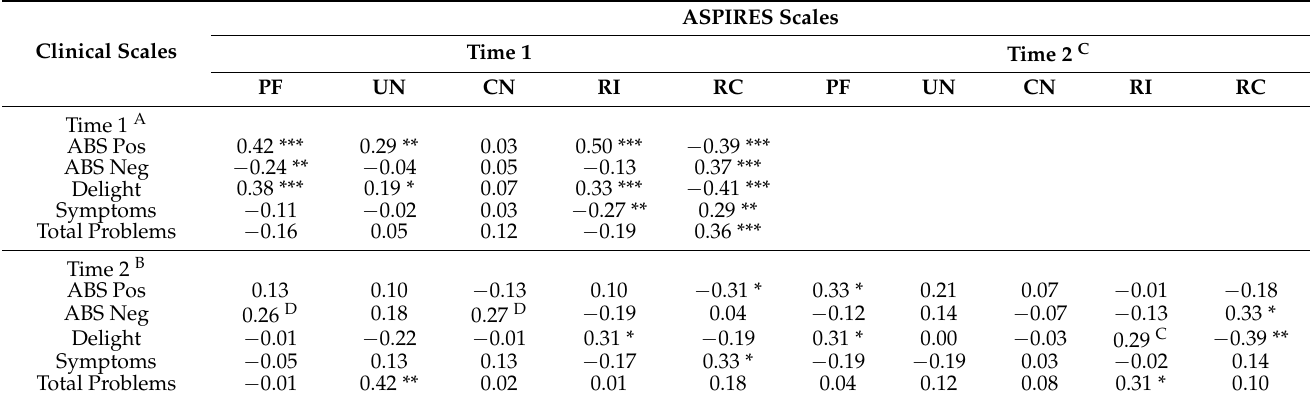
Table 4. Correlations between the ASPIRES Scales and Clinical Measures at Time 1 and Time 2.